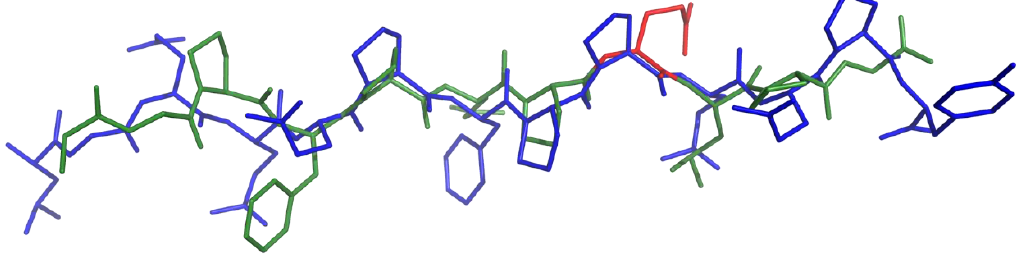
Figure 7. Superimposition of DQ2-α1 (from binary complex PDB code 1S9V, colored in forest with its glutamic acid at P6 colored in red) with P31–43 modelled in PPII structure (blue). The gluten peptides that bind to HLA-DQ8 are di ff erent from those recognized by